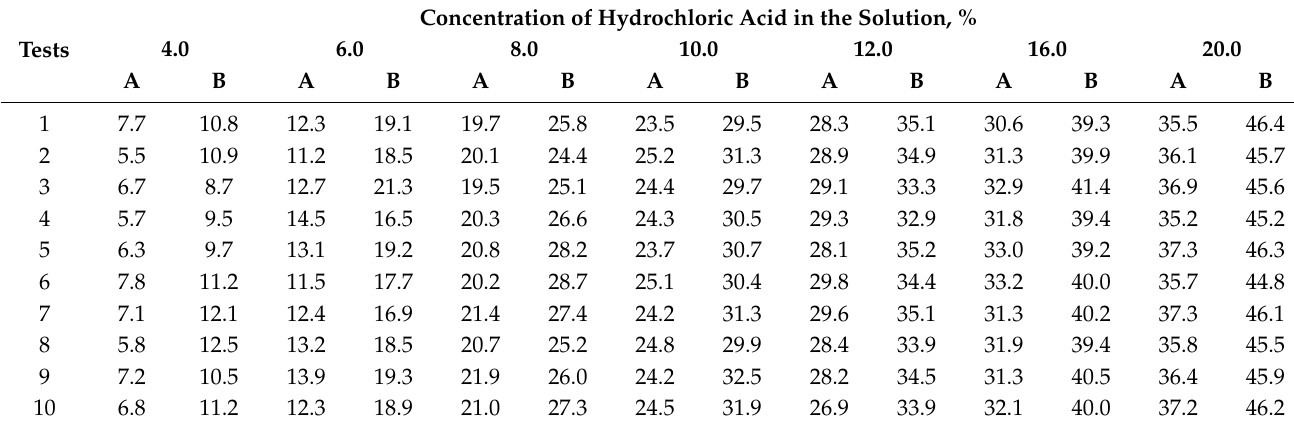
Table 8. Magnesium extraction (%) without mechanical activation (A) and with mechanical activation